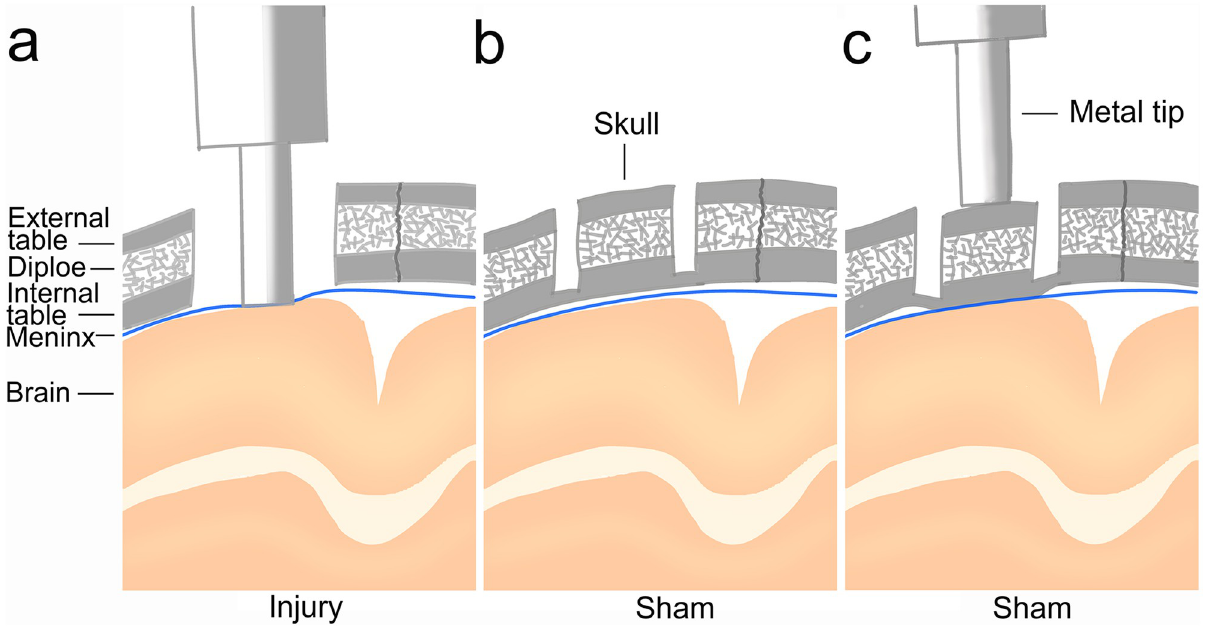
Fig 1. Surgery for the CCI mouse model. (a) In the injury group, the skull was removed, and a rounded metal tip was used to directly impact the brain. (b) For the sham group, resection of the external table and upper part of the internal table of the skull was performed using a drill. (c) The rounded metal tip was pushed into the bone flaps manually to transmit the pressure to the brain via the bone flaps in the sham group.